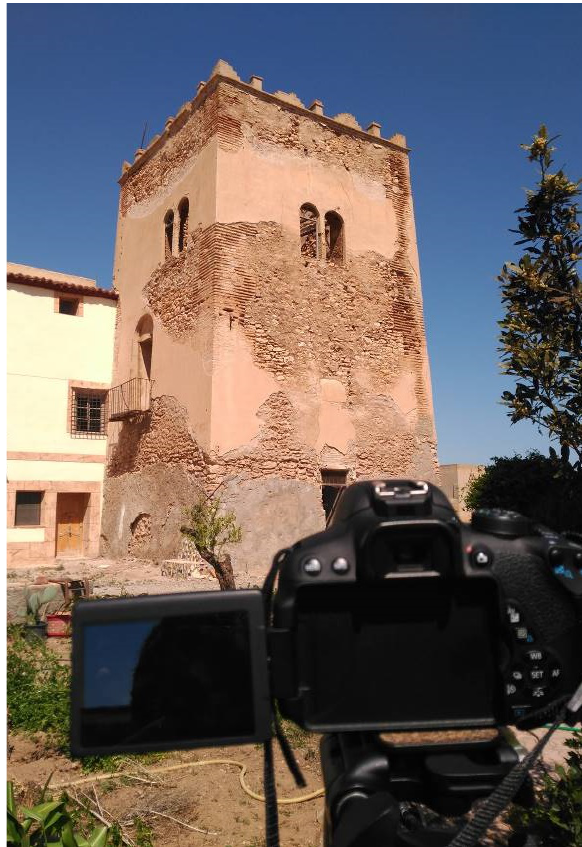
Figure 1. The Negro Tower during the photographic process used for the digital terrestrial photogrametry. Own production.